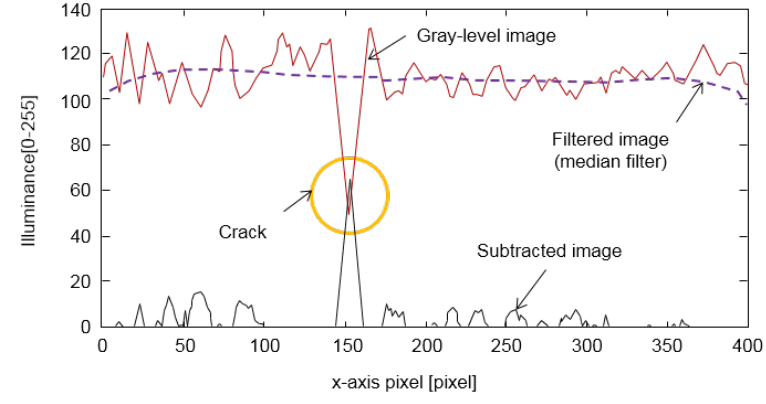
Figure 4. Crack visualization by subtraction processing [41].